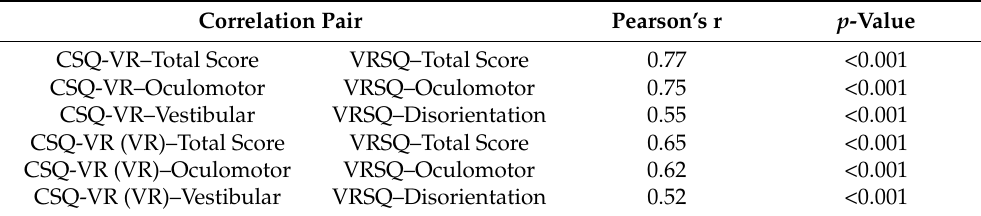
Table 4. Correlations between the scores of CSQ-VR (both versions) and the VRSQ.